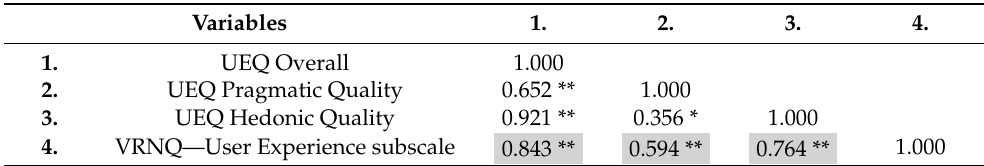
cients for combined measures ( n = 4).